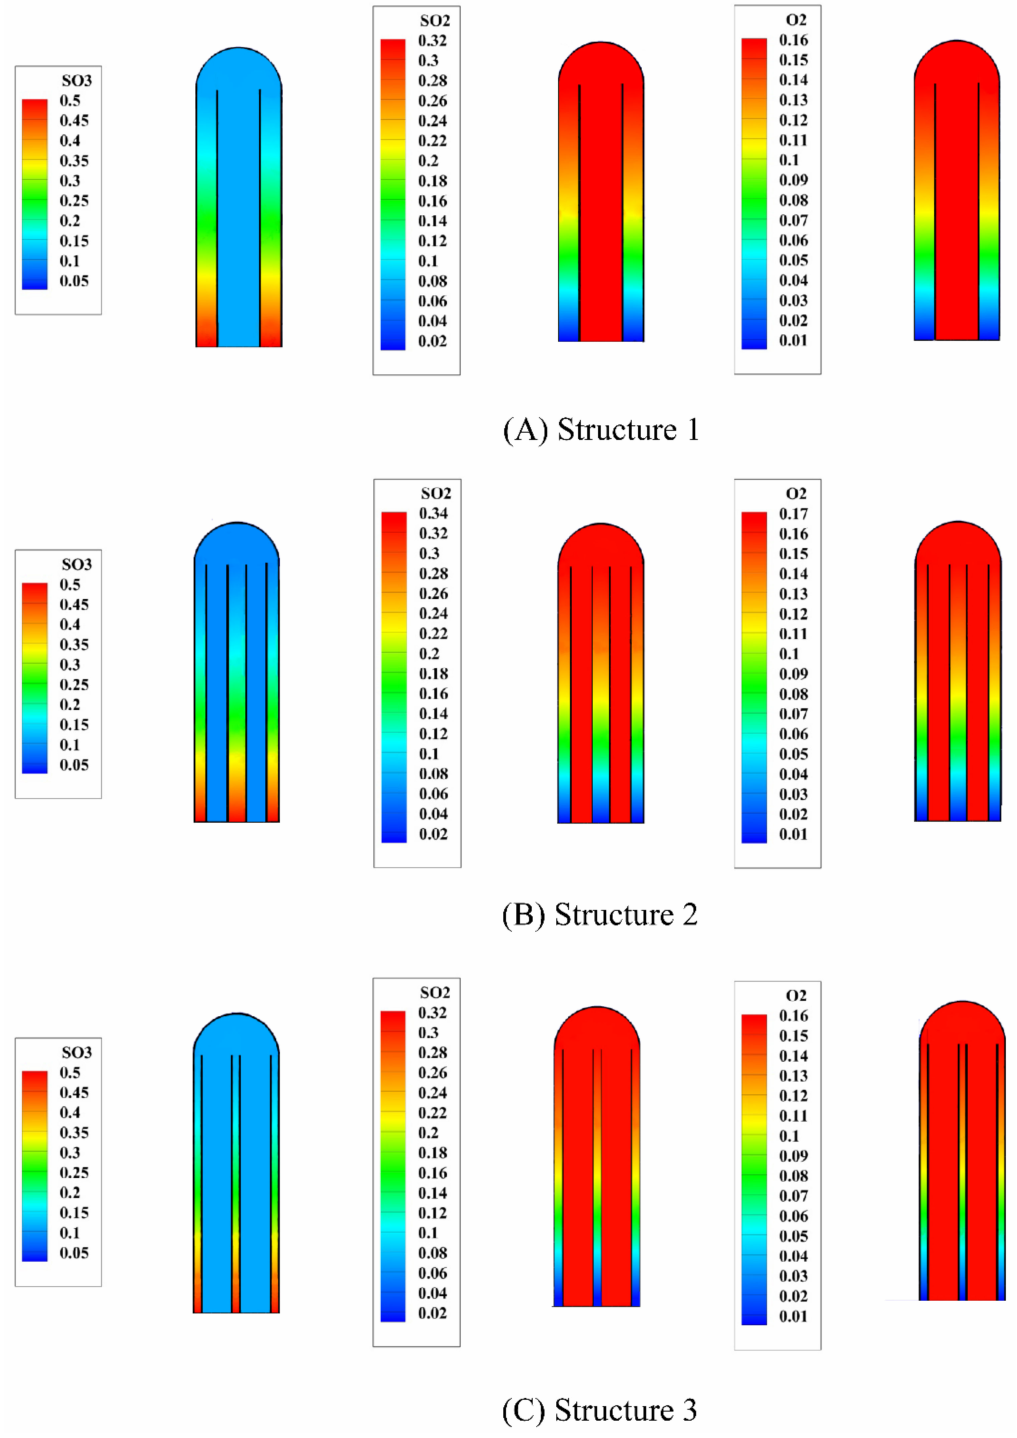
Figure 9. Spatial distributions of the species molar fractions in the bayonet heat exchanger for an inlet flow rate of 0.00035 kg/s. ( A ) Structure 1, ( B ) Structure 2, ( C ) Structure